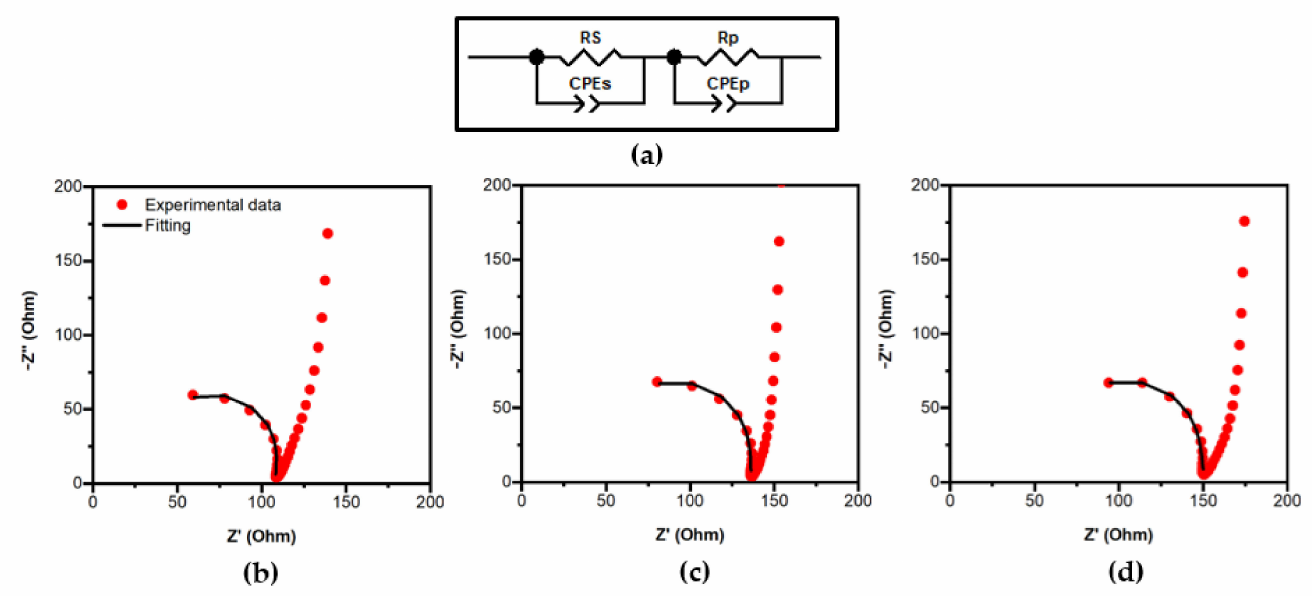
Figure 9. Nyquist plot and electrical equivalent circuit for substrate–layers samples: ( a ) Equivalent circuit; ( b ) Nyquist plot for TiO 2 -GC/ITO; ( c ) Nyquist plot for TiO 2 -GB/ITO; and ( d ) Nyquist plot for TiO 2